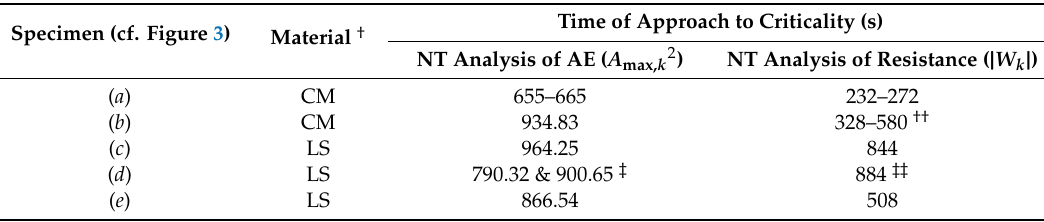
Table 2. NT analysis results for the AE and electrical resistance time series of mortar enriched with iron oxide and Luserna stone specimens tested (cf. Figure 3).